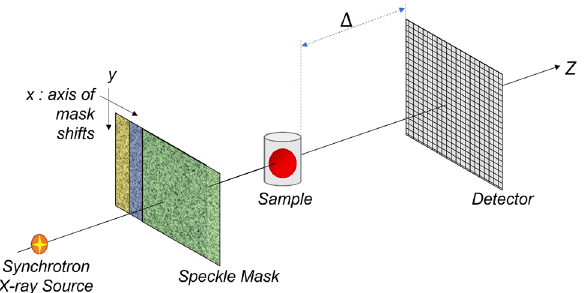
Figure 1. Experimental setup of speckle-based phase-contrast X-ray imaging using a synchrotron X-ray